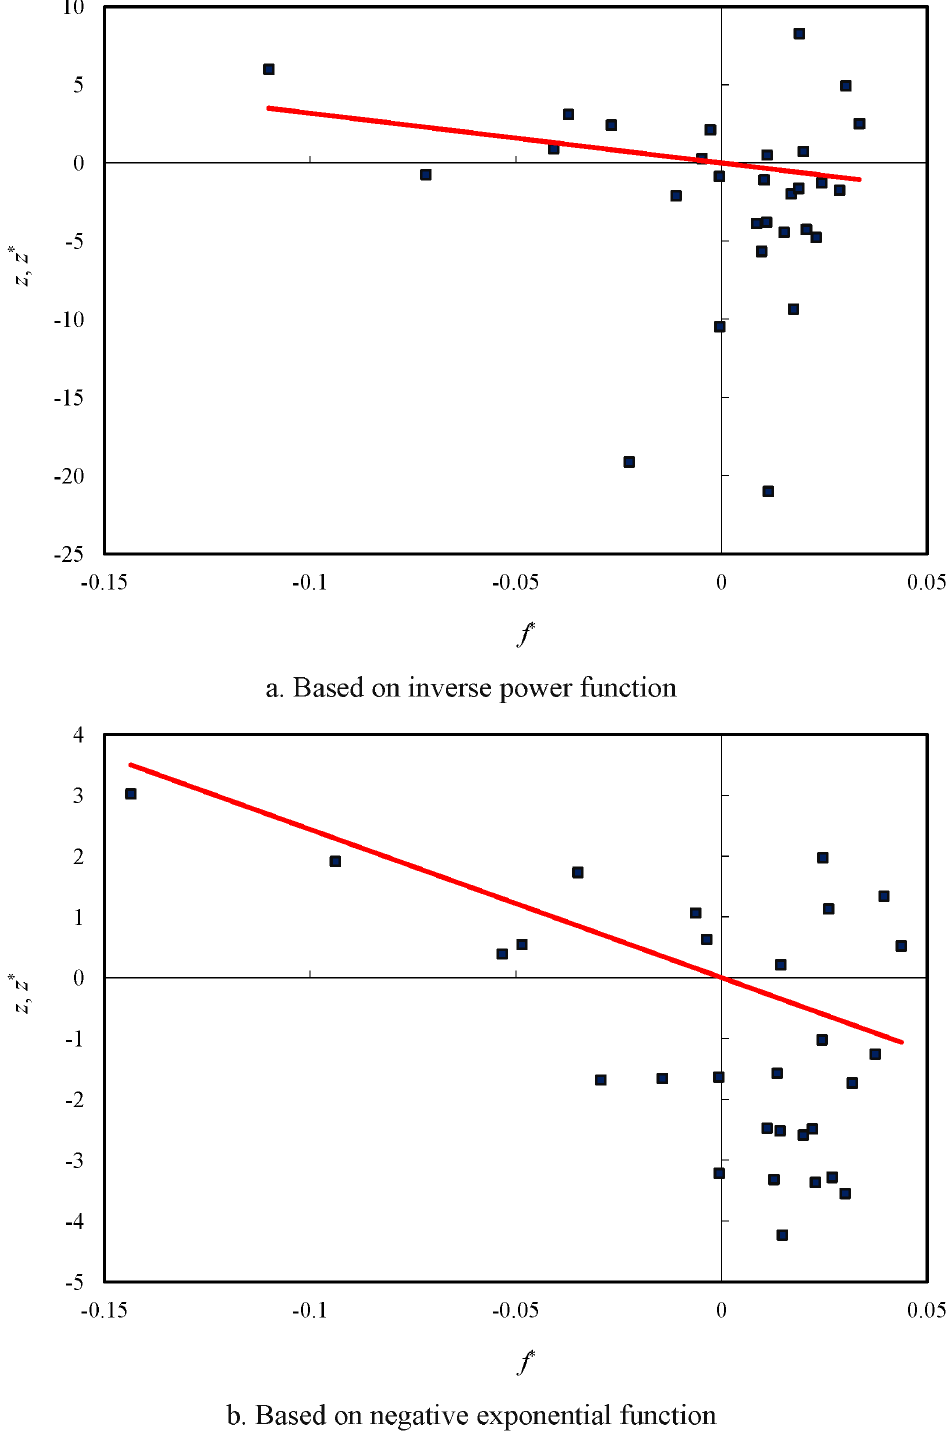
Figure 4. The inverse Moran’s scatterplots with trendlines of spatial autocorrelation for the principal cities of China (2000). [a. Based on inverse power function; b. Based on negative exponential function].